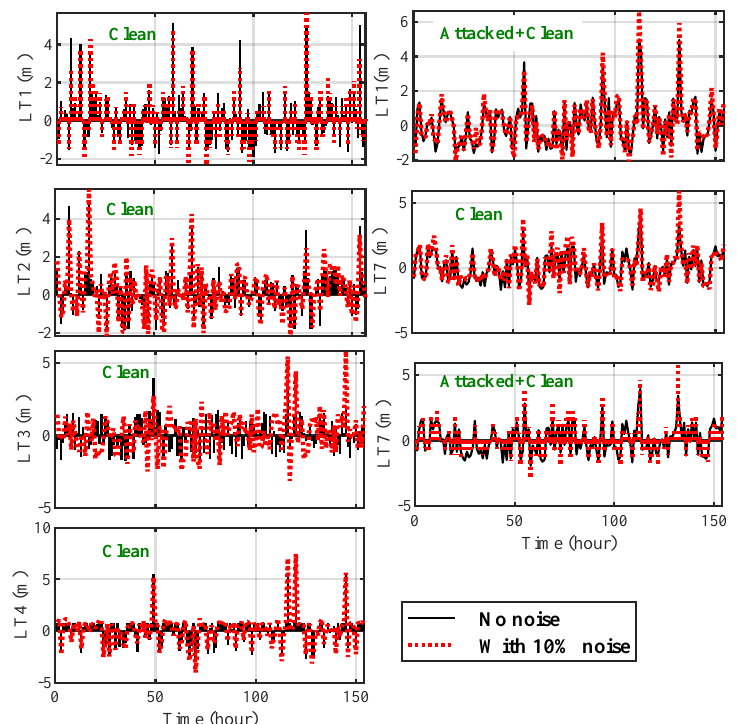
Figure 8. Clean and bad data measurements of tank 1 (LT1), tank 2 (LT2), tank 3 (LT3), and tank 4 (LT4) considering 10%